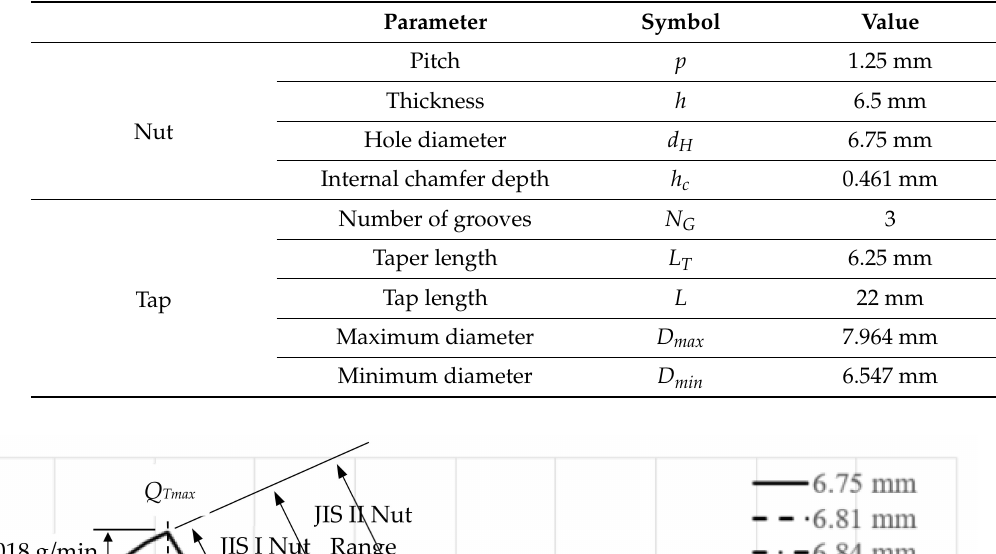
Table 2. The parameters of the nut and tap.